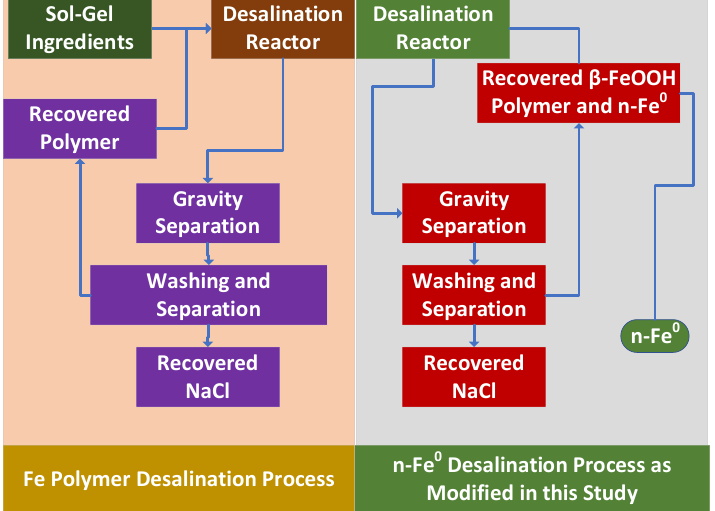
Figure 16. Comparison of polymer desalination using a sol gel approach to polymer manufacture and n-Fe 0 as the polymer source.